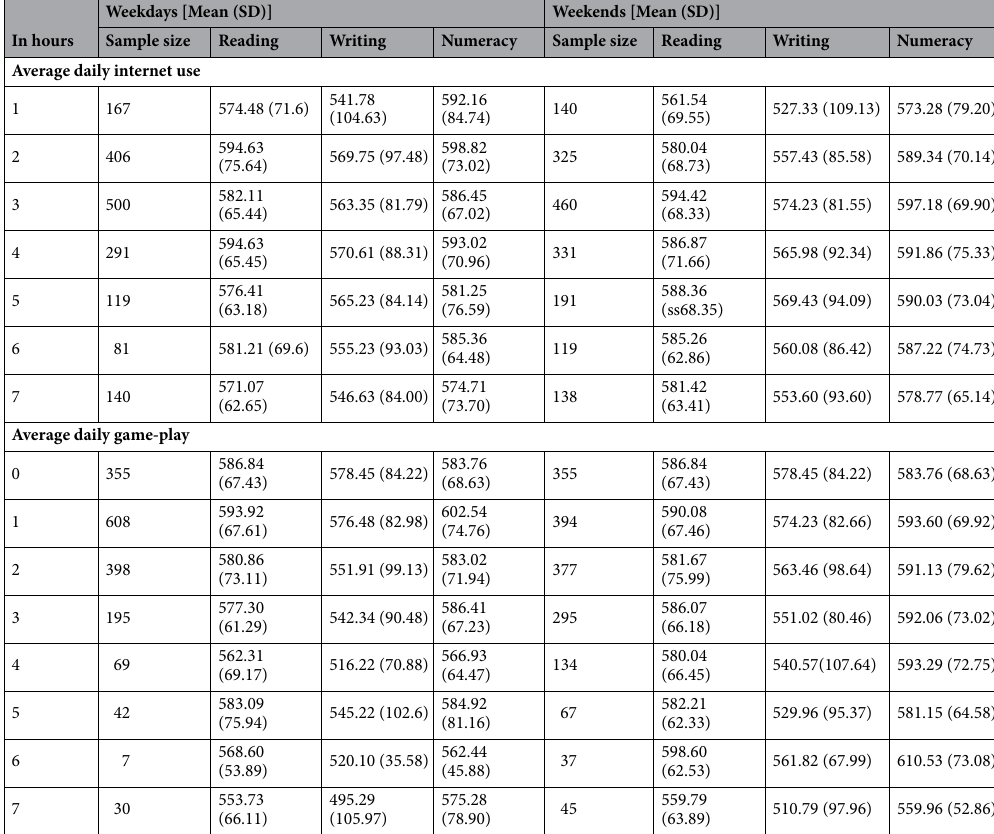
Table 2. Average NAPLAN scores for reading, writing and numeracy across average daily internet use and average daily